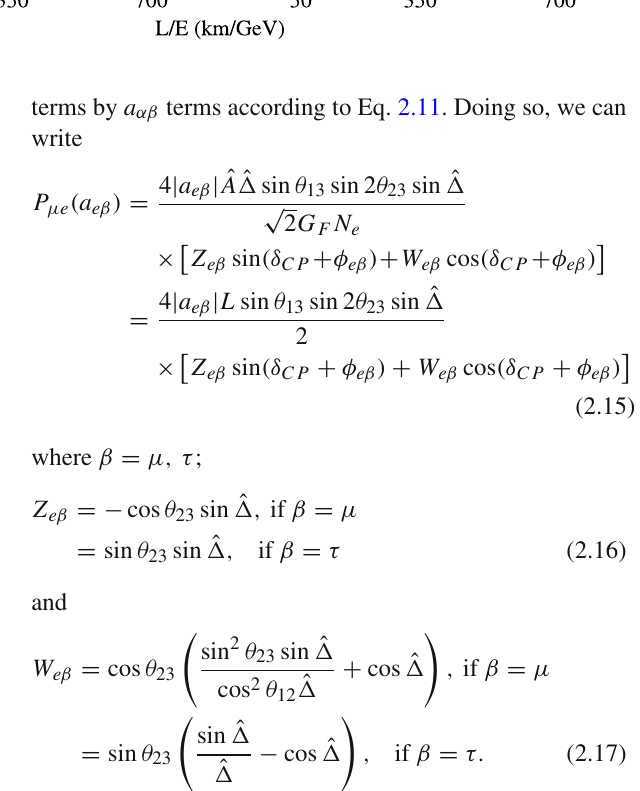
Fig. 5 Ratio of the LIV to standard oscillation probabilities as a function of L / E and δ CP . The reference energy E = 2 . 0 GeV has been fixed to the NO ν A flux peak energy. For this peak energy and NO ν A baseline, L / E = 405 km/GeV. The upper (lower) panel shows the ratio for NH (IH), the left (right) panel shows it for neutrino (anti-neutrino). | a | and | a | have been fixed e μ e τ at 2 × 10 − 23 GeV each and